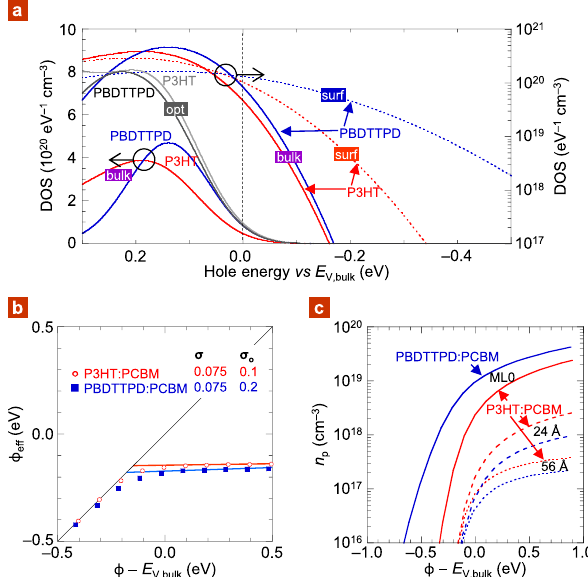
Fig. 4 Computational study of DOS effects with semiempirical model.